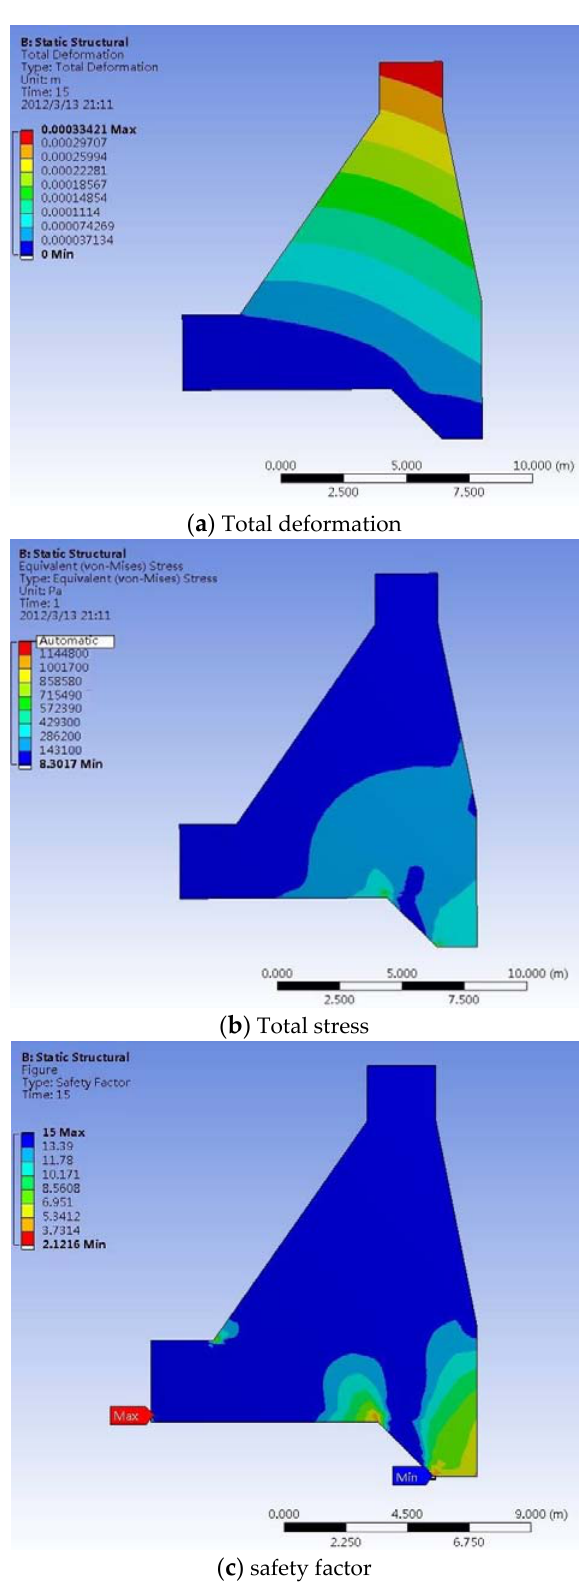
Figure 14. Total deformation, total stress, and safety factor of Barrier 01.